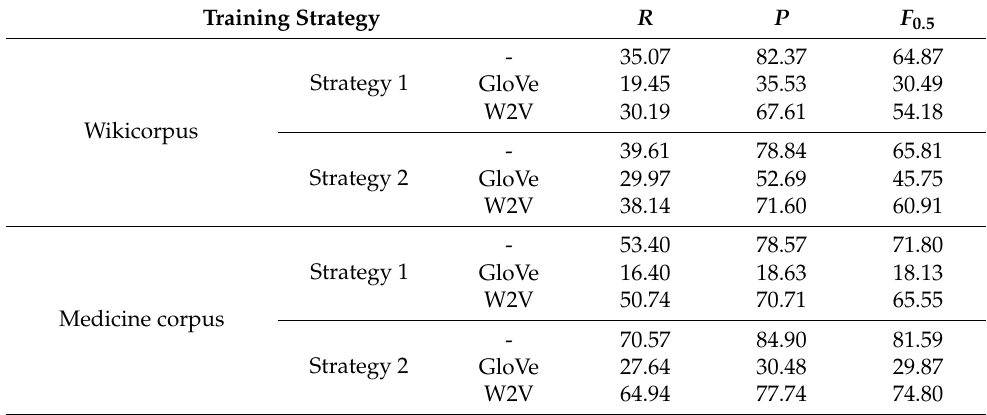
Table 11. Recall ( R ), precision ( P ) and F 0.5 for the evaluation of genre-number error correction. Training Strategy